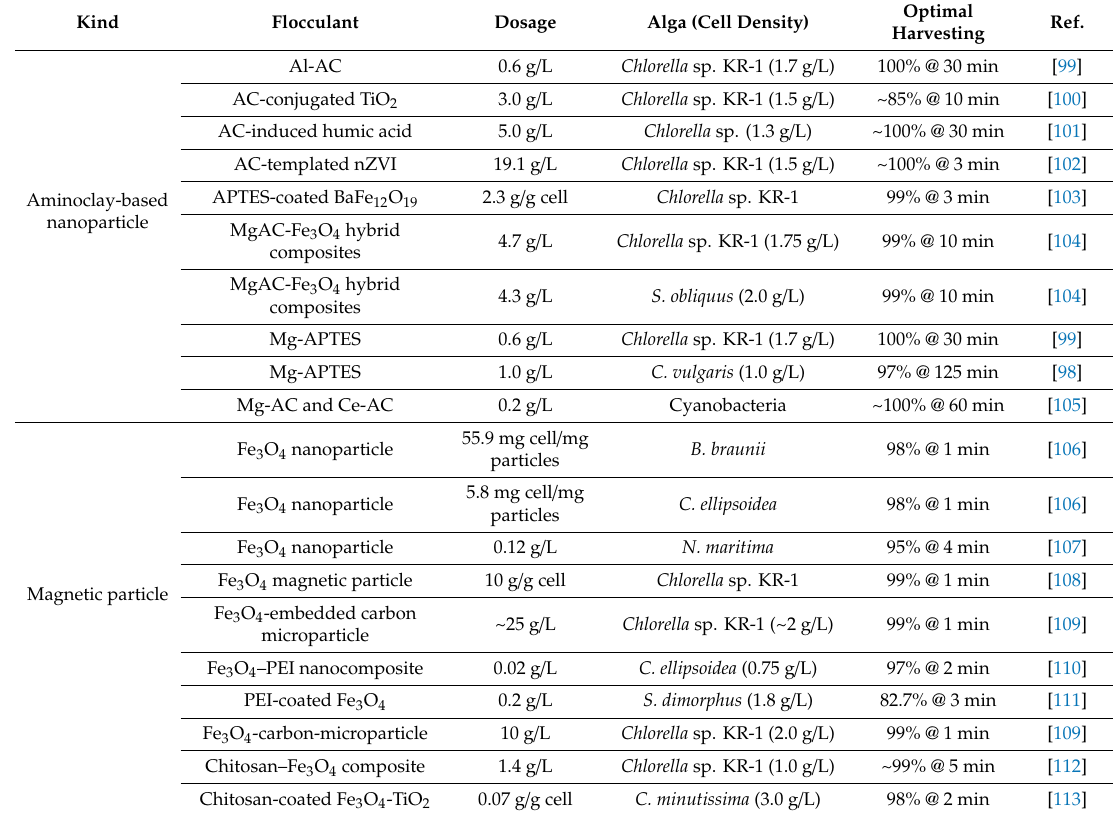
Table 4. Comparison of particle-based flocculants for algae